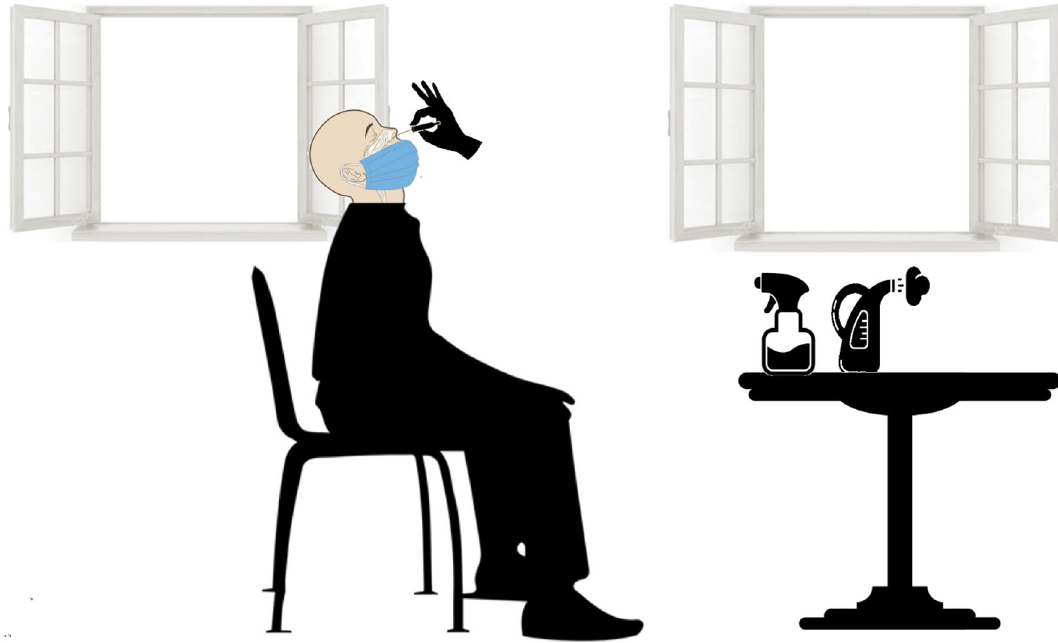
Figure 6. Proper sampling conditions for COVID-19 by nasopharyngeal swabs should provide good ventilation and light, washable surfaces and walls, readily available and safe decontaminants for ambient air and surfaces in the form of sprayer or steamer, while participants should be advised to keep their masks on their faces and only removing it from the nose area during the specimen collection to limit viral spreading by coughing or sneezing and to prevent breathing in aerosolized viral particles by only breathing through their mouth during the procedure. A careful swabbing technique can prevent most complications, even painfulness and sneezing. When inserting the swab along the nasal septum and bottom of common nasal meatus below the inferior turbinate, it is important never to touch the inferior